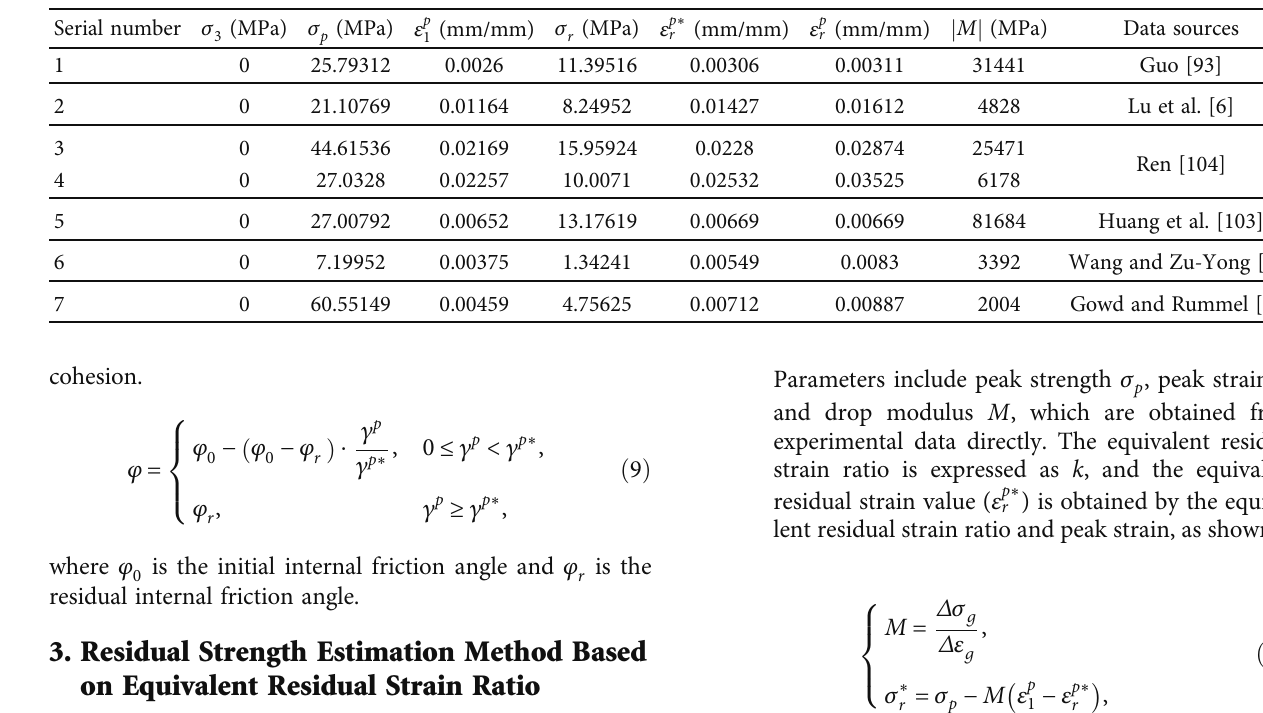
Table 6: Mechanical parameter statistics of complete stress-strain curves of soft rock during the uniaxial